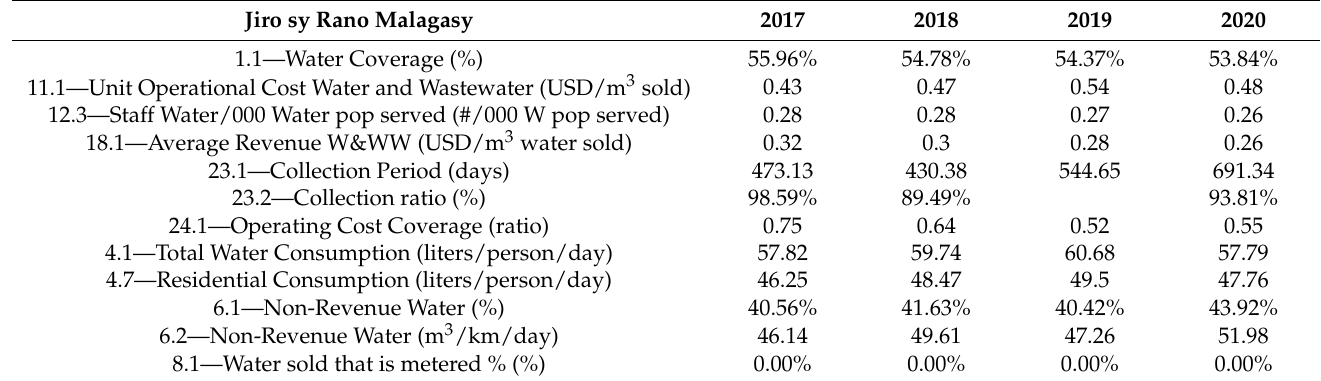
Table 1. Benchmarking of water utilities in Madagascar from 2017 to 2020.